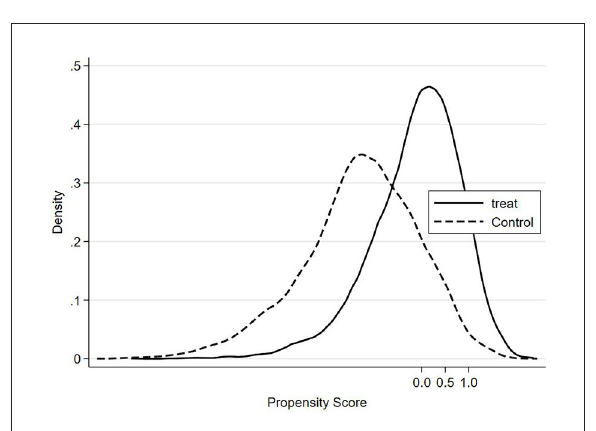
FIGURE3 Density distribution of the propensity score (After